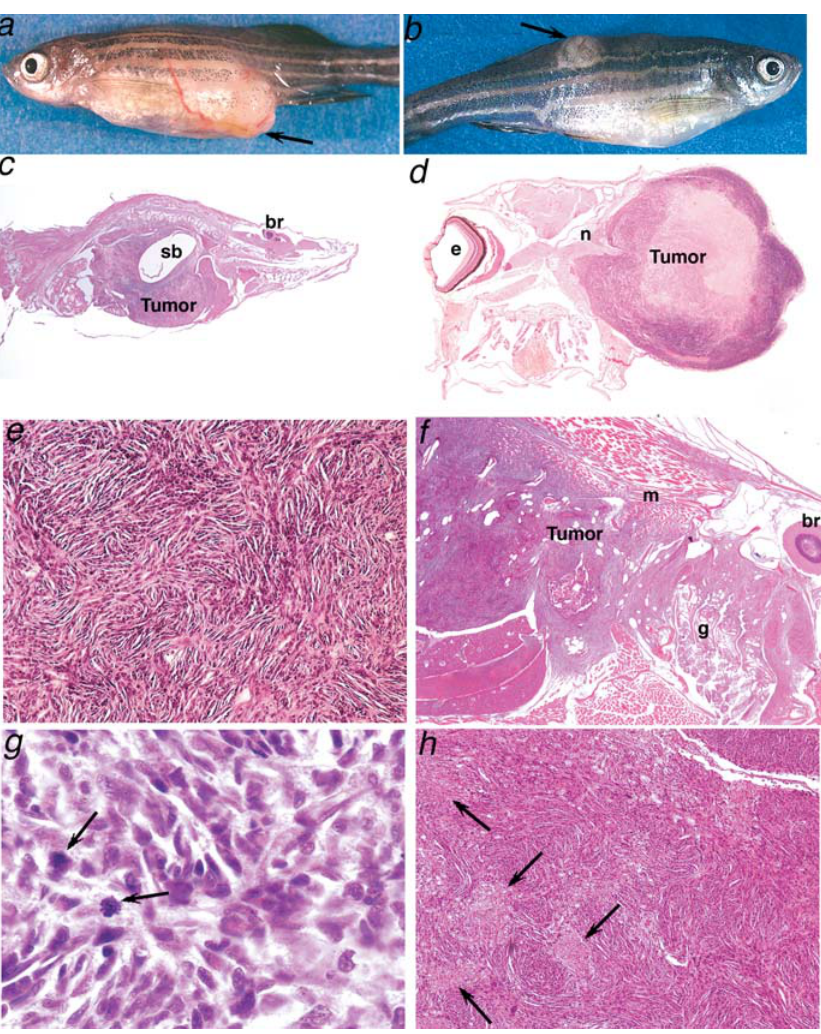
Figure 1. Spindle Cell Tumors Resembling MPNSTs in Zebrafish Heterozygous for Mutations in RP Genes (A and B) Fish with apparent masses, as indicated by the arrows, or other evident pathology were selected for histological analysis: (A) a hi2582 fish, (B) a hi1034B fish. (C–H) Histopathology of representative tumors stained with hematoxylin and eosin reveals patterns consistent with the diagnosis of MPNST in hi10 fish (C and D), hi1974 fish (E–G), and hi1807 fish (H). (C) Tumors typically filled the entire abdomen (sb, swim bladder; br, brain) (80 3 ). (D) A large tumor with central necrosis is seen emanating from the optic nerve (n) (e, eye) (20 3